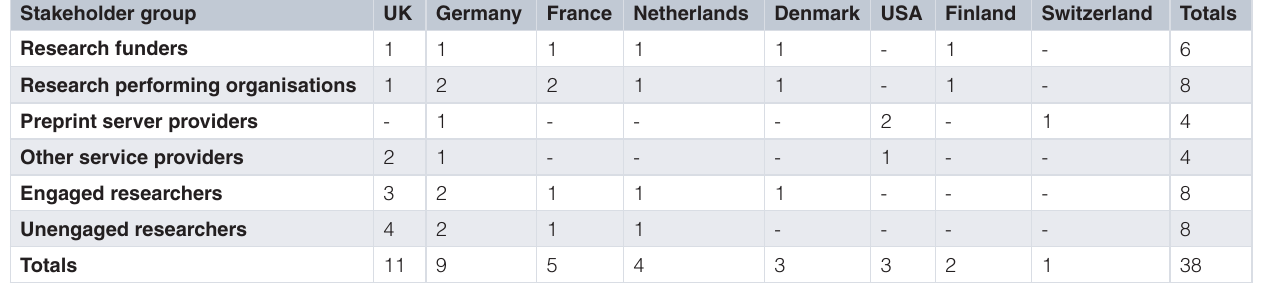
Table 3. Participants by role and country (n=38). Participants are listed by Chiarelli et al. (2019b). Stakeholder